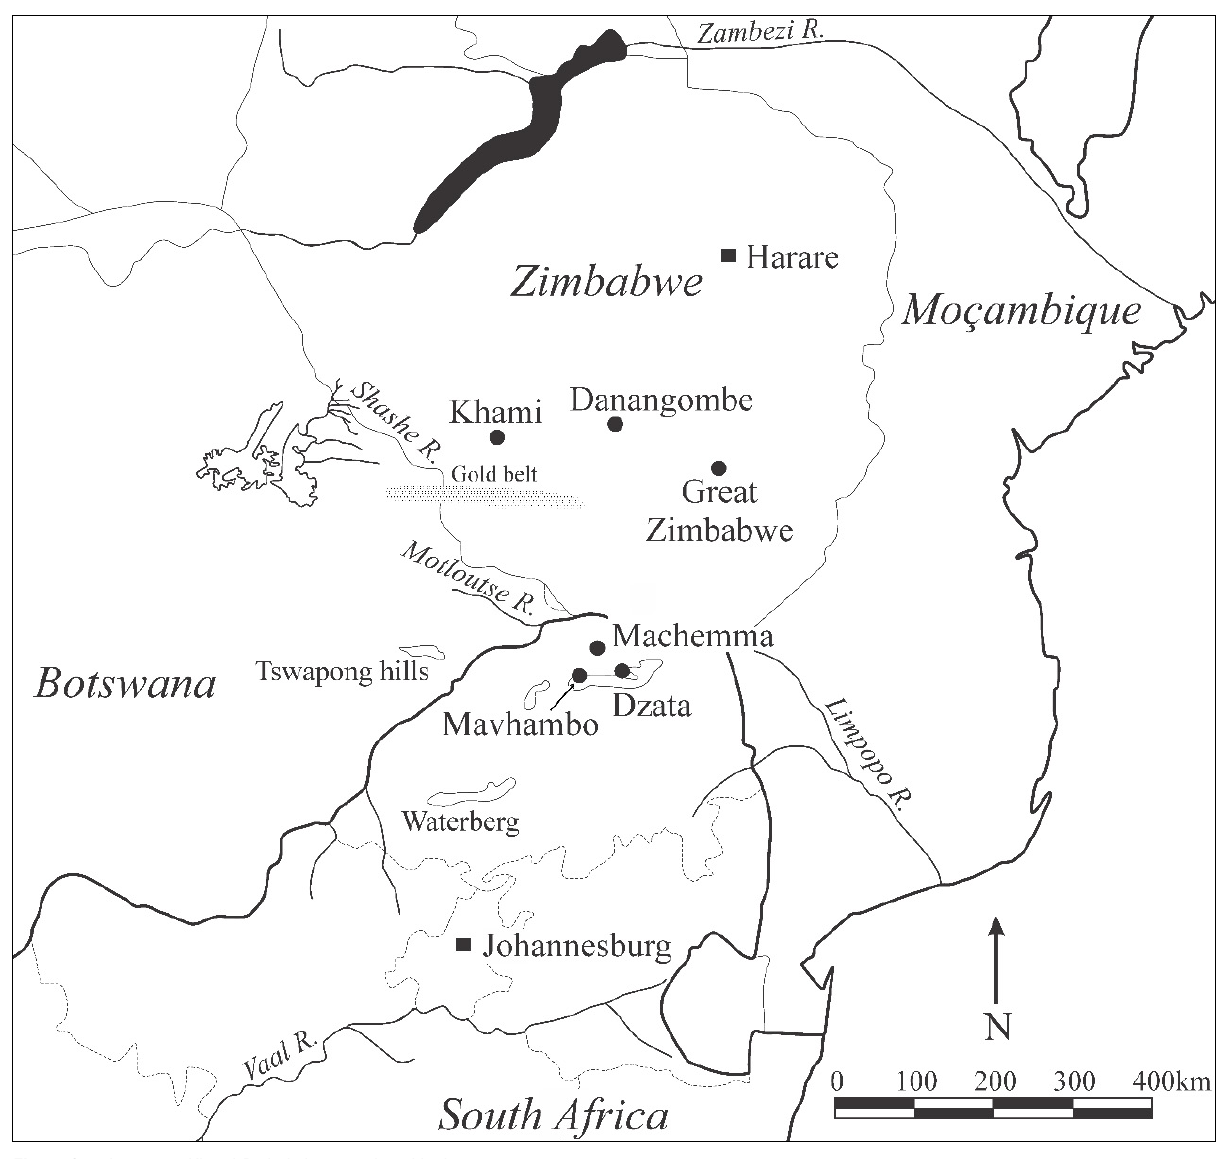
Figure 1: Important Khami-Period sites mentioned in the